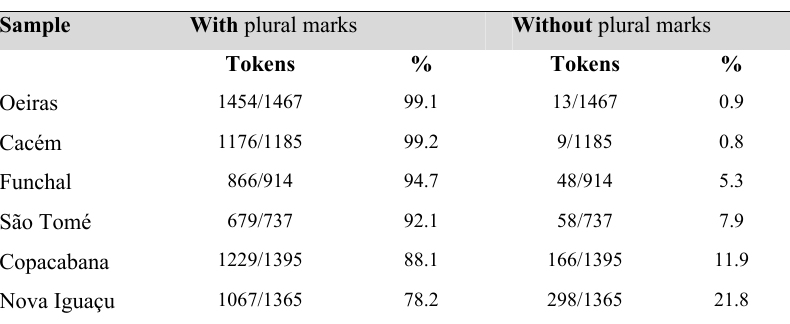
Table II: Distribution of occurrences of third person plural verbal agreement with and without plural marks within urban varieties of Portuguese Third person plural verbal